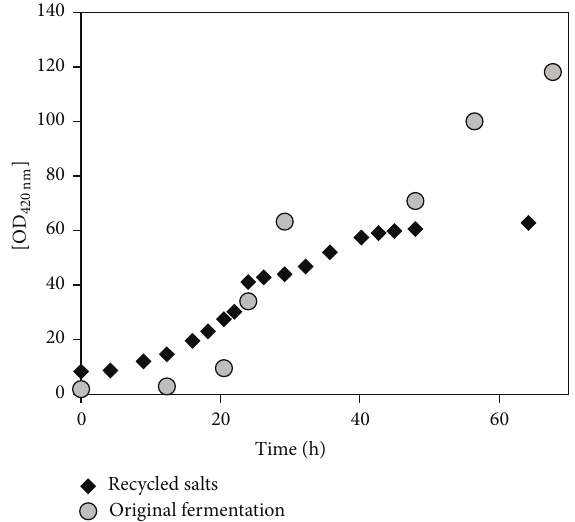
Figure 3: Comparison of time curves of optical density [OD 420 of the “original” fermentation and the recycling experiment on salty spent supernatant (SSF); cultivations of H. mediterranei DSM 1411 on whey as main carbon